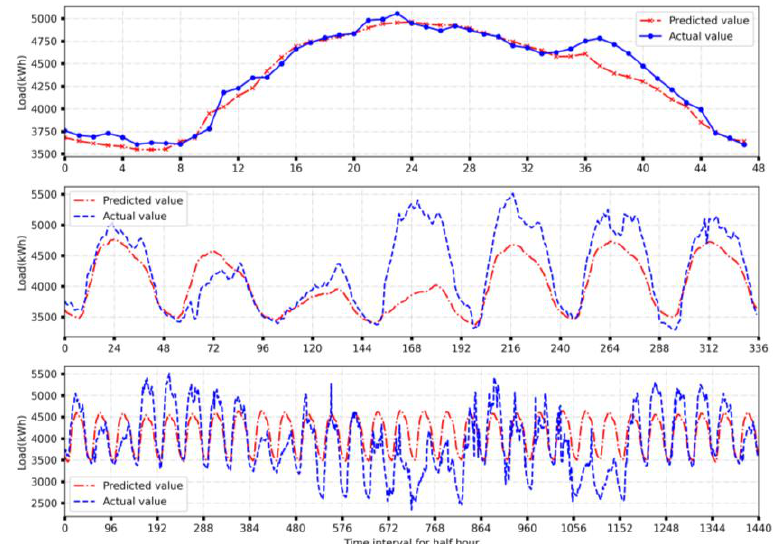
Figure 14. LSTM blind test.